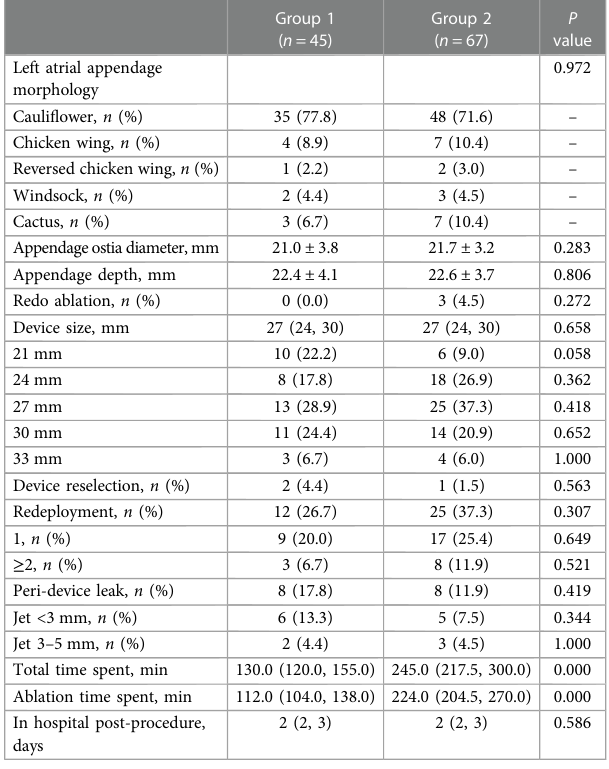
TABLE 2 Periprocedural